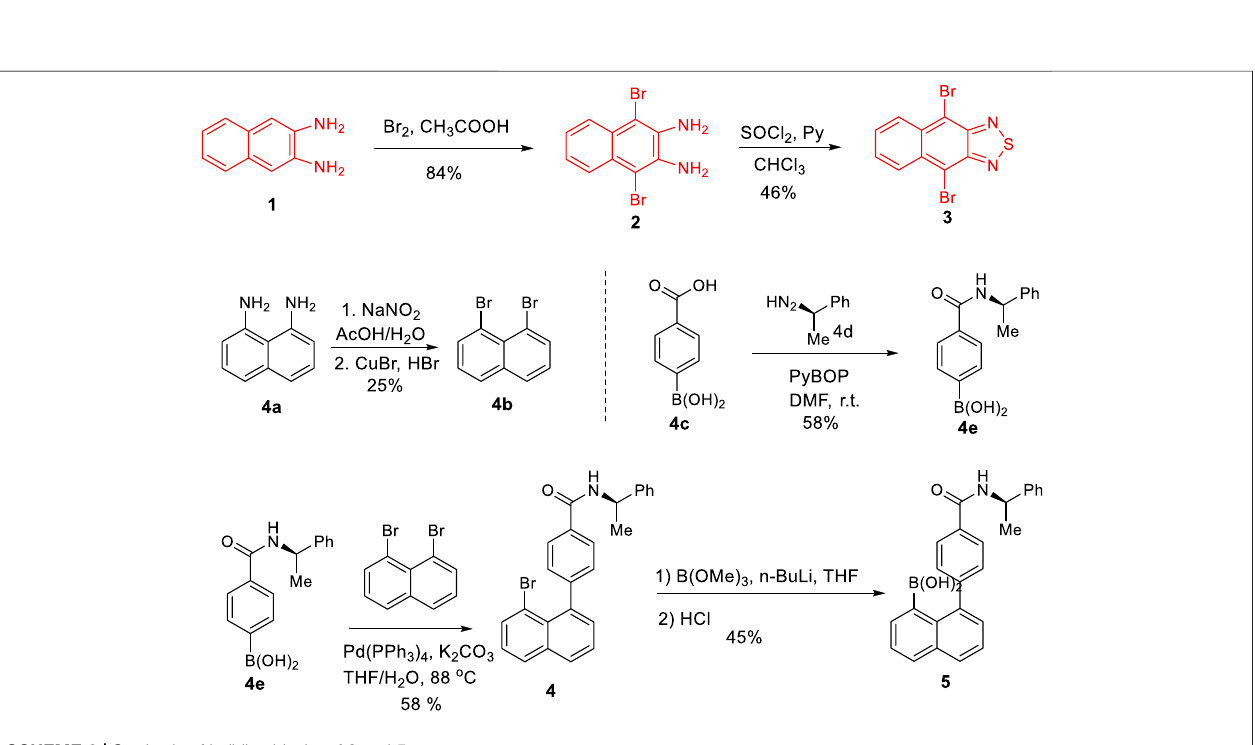
SCHEME 2 | Synthesis of building blocks of 3 and 5